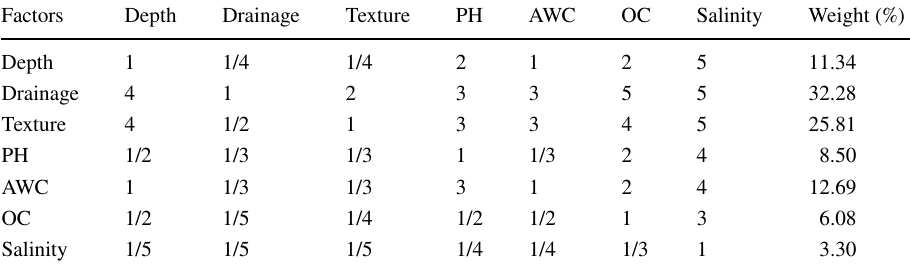
Table 8 Results of the weight of soil